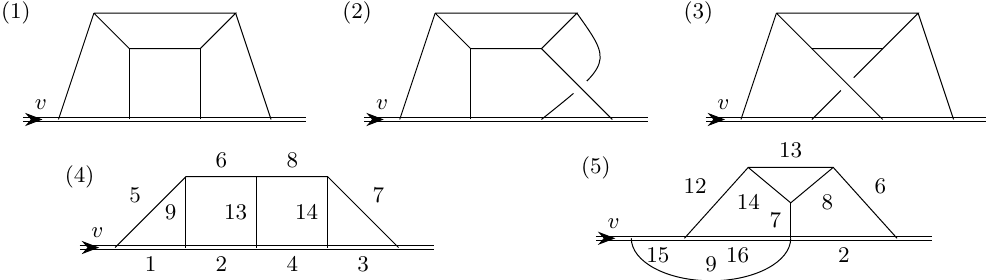
Figure 2 . Integral topologies of the master integrals of all n f dependent color structures of the cusp anomalous dimension in the small angle